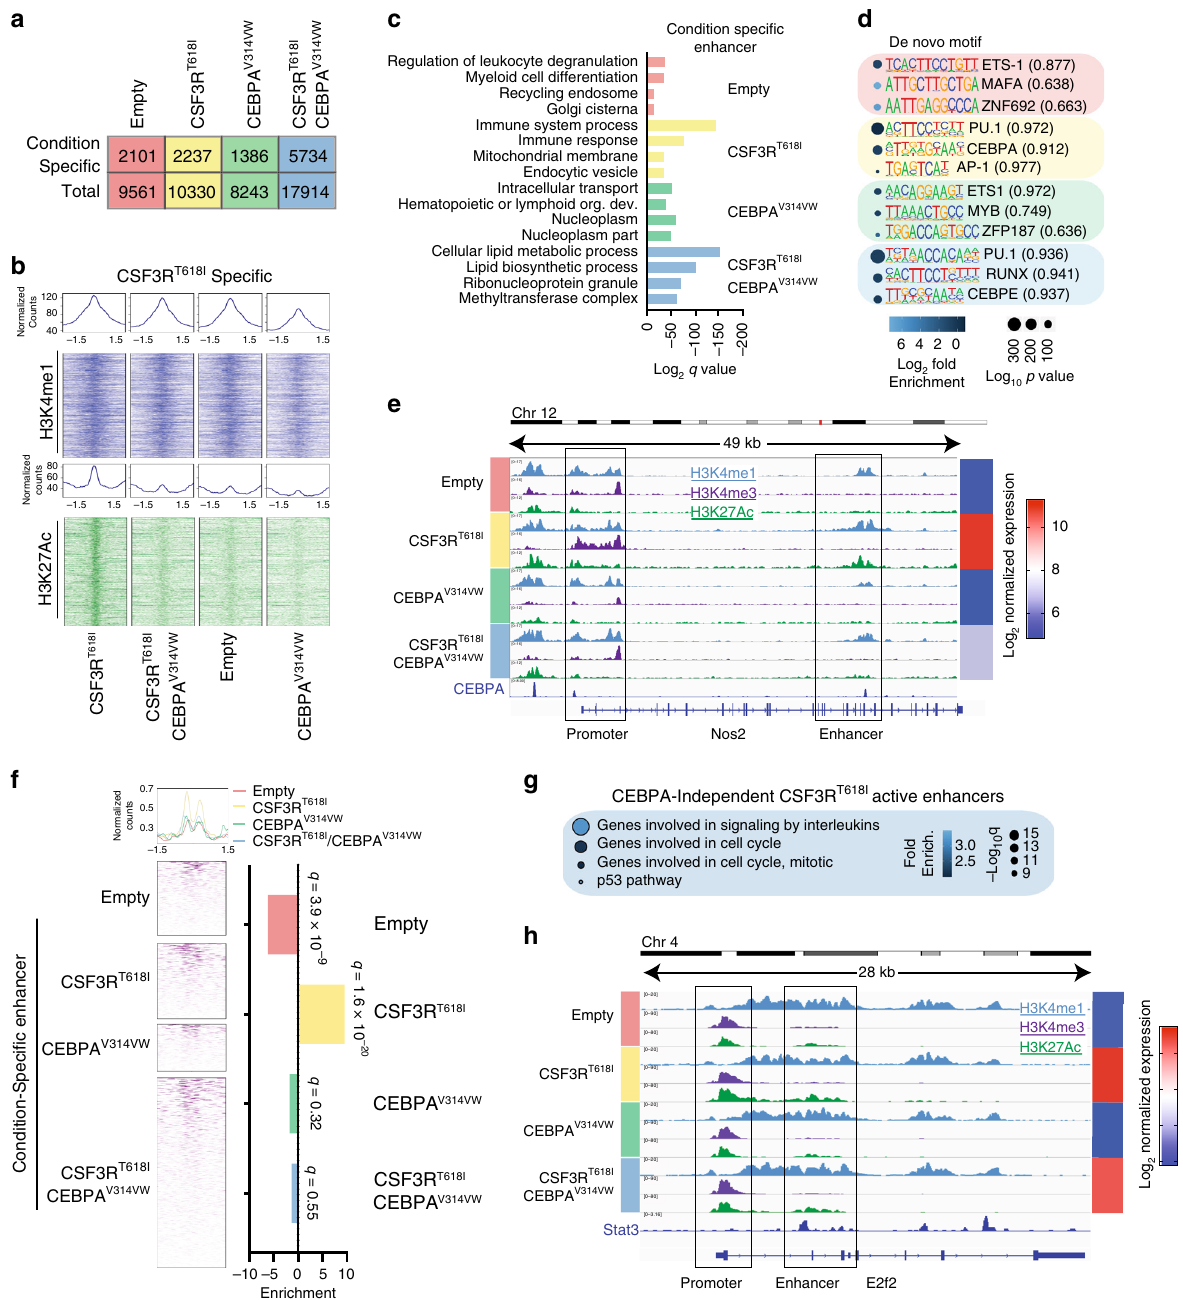
Fig. 5 CEBPA mutations disrupt activation of myeloid lineage enhancers. a Number of condition-speci fi c enhancers identi fi ed in this study. b ChIP-seq heat maps for H3K4me1 and H3K27ac at + 1.5 kb around the center of CSF3R T618I -speci fi c enhancers, across treatment conditions. ChIP tracks display fold enrichment relative to corresponding input. c Gene ontology analysis for condition-speci fi c enhancers. P values generated via comparison to binomal distribution and FDR adjusted. d De novo motif enrichment in condition-speci fi c enhancers. Values in parenthesis correspond to motif match score. P values generated via comparison to binomal distribution and FDR adjusted. e The epigenetic landscape at the Nos2 locus demonstrates condition-speci fi c promoter and enhancer activation. f Assessment of CEBPA ChIP-seq peak overlap with condition speci fi c enhancers by χ 2 test with Pearson residual values plotted. Adjusted p values (by the method of Holm – Bonferroni) are displayed above bars. g Gene ontology analysis for CEBPA-independent CSF3R T618I active enhancers. h The epigenetic landscape at the E2f2 locus demonstrates enhancer activation in response to CSF3R T618I . Source data are provided as a Source Data fi